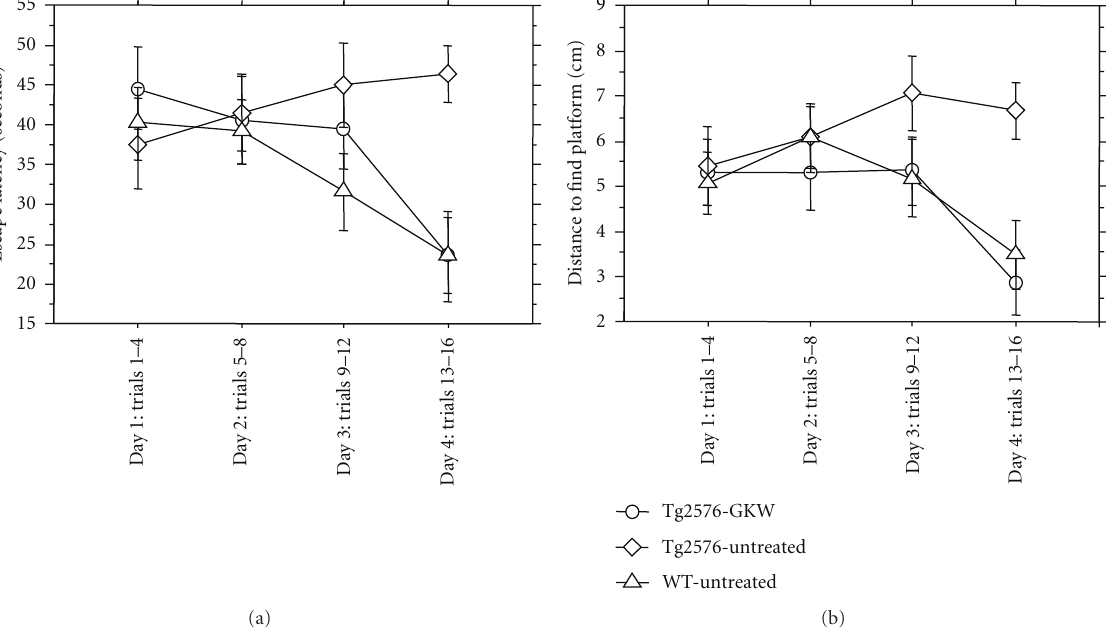
Figure 2: GKW e ff ects in the Morris water maze . Mean ± SEM of (a) escape latency and (b) distance traveled to find platform is shown for each day of testing. Wild-type animals exhibit a “learning curve” requiring less time and less distance to find the hidden platform with repeated trials, while untreated Tg2576 mice require equivalent time and distance despite repeated exposures. In contrast, the GKW-treated mice learn in a manner similar to the wild-type animals, with latency and distance traveled to find the platform declining with repeated exposures. On day 4, time to find the platform was significantly greater for untreated Tg2576 mice than for wild-type ( P = 0 . 002) or GKW- treated Tg2576 mice ( P = 0 . 004). Distance traveled to find the platform was also significantly greater on day 4 for untreated Tg2576 mice compared to wild-type ( P = 0 . 006) or GKW-treated Tg2576 mice ( P = 0 .